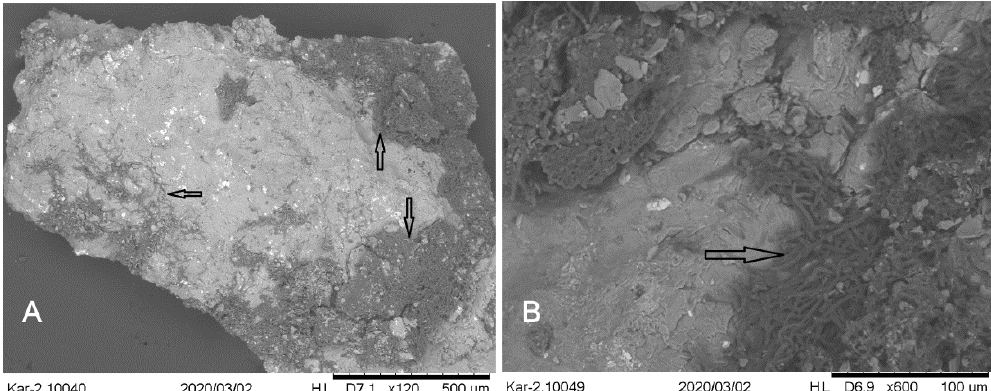
Figure 9. Rock colonization by micromycetes (arrows) (SEM data): ( A ) formation of biofilm within the predominance of micromycetes on the edge areas of a stone sample; ( B ) boundary of the micromycetes’ net and uncovered rock surface.